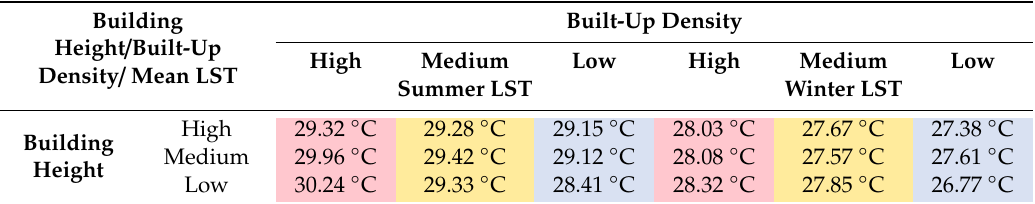
Table 5. LST characteristics of different landscape patterns of the built-up area.